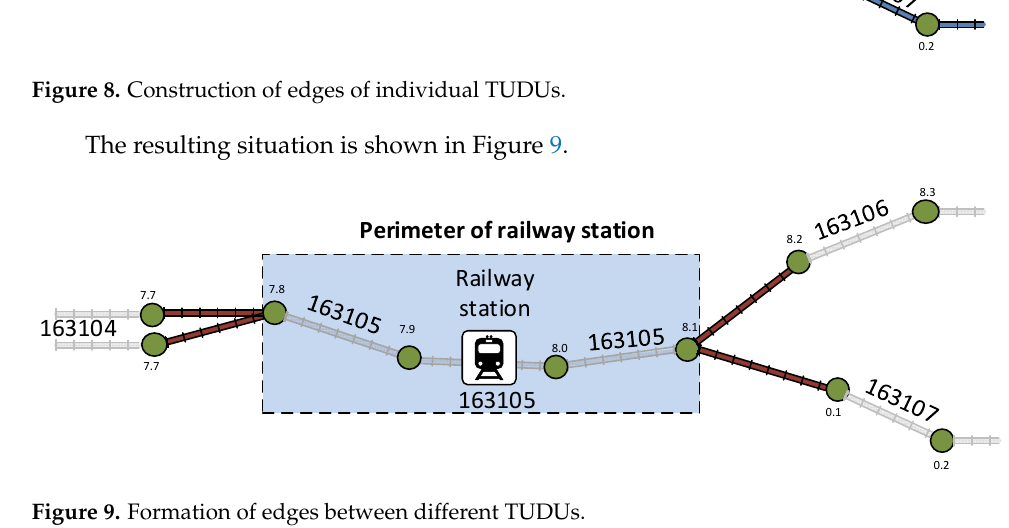
Figure 7. Illustration of algorithm used for the formation of vertices. Algorithm 2. Construction of edges within one TUDU.